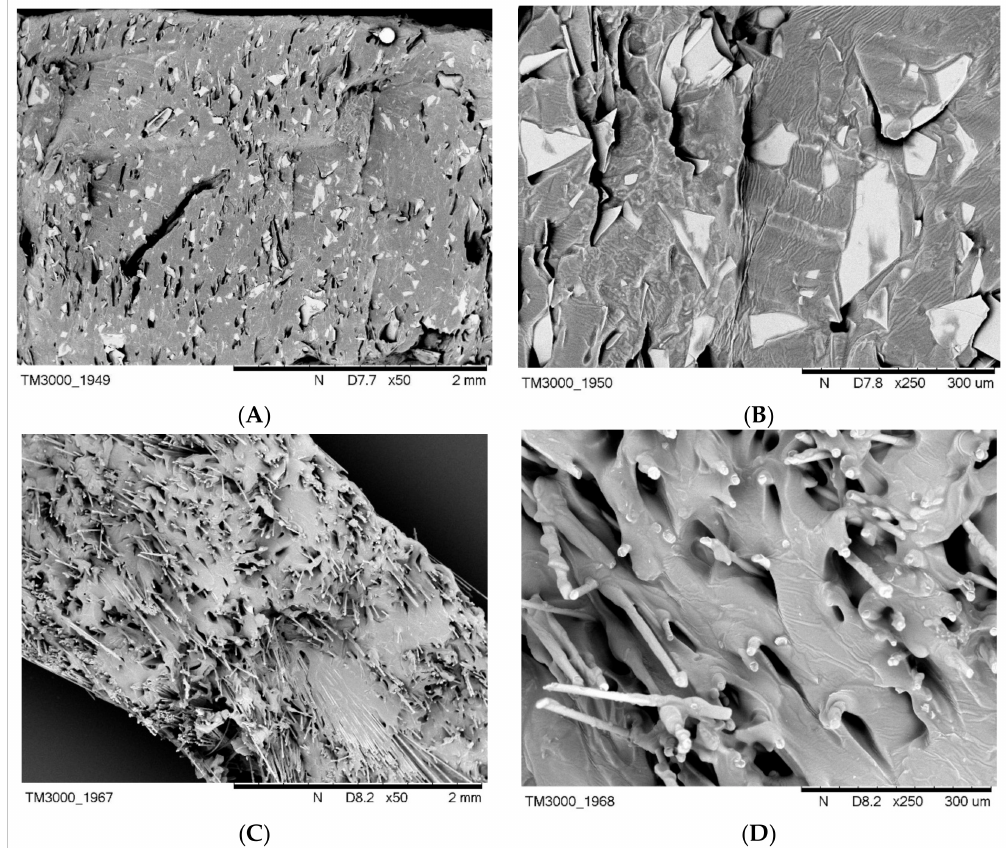
Figure 7. SEM images of non-vulcanized mixtures: ( A ) SR-3 × 50; ( B ) SR-3 × 250; ( C ) SR-4 × 50, ( D ) SR-4 ×